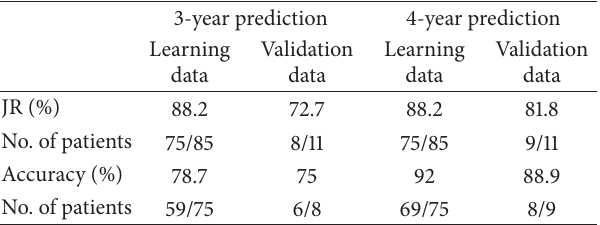
Table 6: Estimation of 3- and 4-year outcome prediction for unlearned data